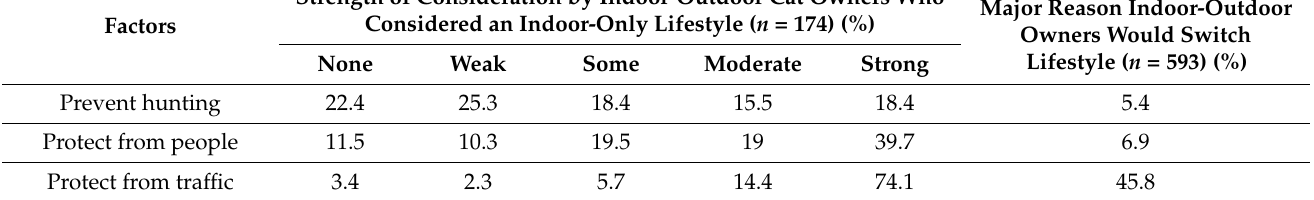
Table 8. Indoor-outdoor owners who considered an indoor-only lifestyle for their cat ( n = 174) and the reported level of consideration given to different factors when making their decision and the percentage of indoor-outdoor cat owners ( n = 593) who gave different reasons when asked for major factors that would cause them to change their cat to an indoor-only lifestyle would